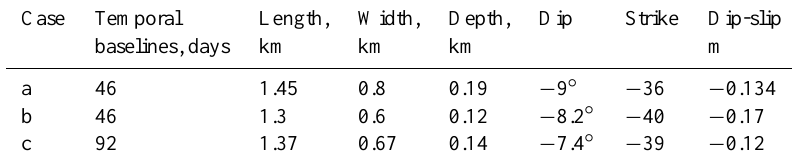
Table 1. Output parameters from inversion model for different interferograms (Fig. 8a–c).